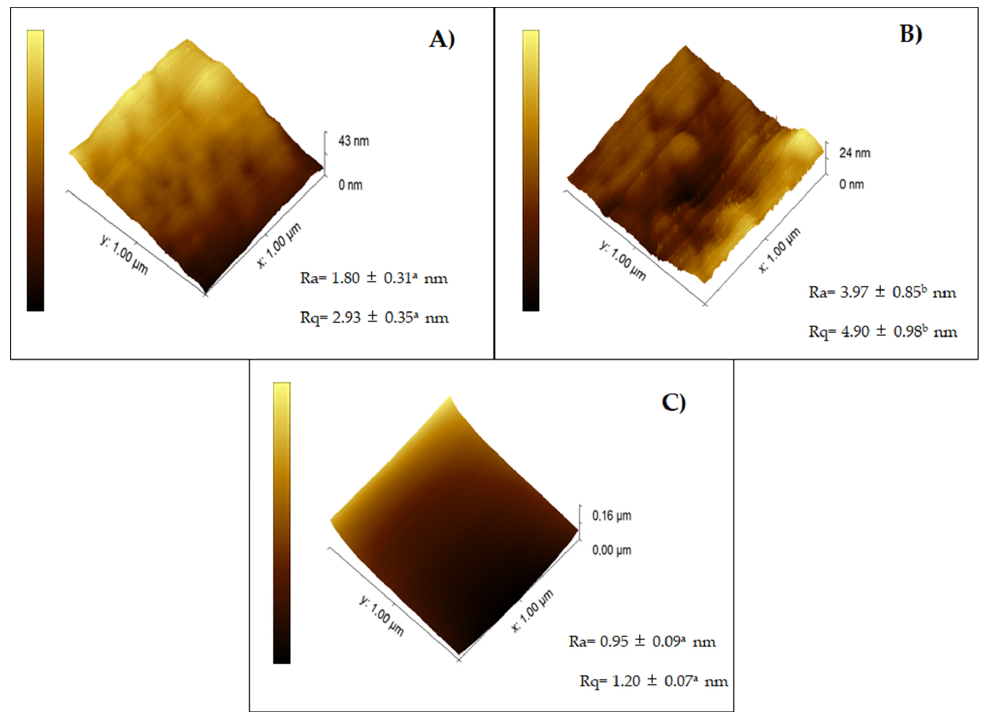
Figure 2. Films’ topography. ( A ) Cellulose–Chitosan film, ( B ) Cellulose–Nanocrystals–Chitosan film and ( C ) Chitosan film. Ra: Arithmetic roughness average of the surface; Rq: Root mean square average of the profile heights over the evaluation length. Different lowercase letters (a and b) next to the reported values in the same parameter indicate significant differences ( p <